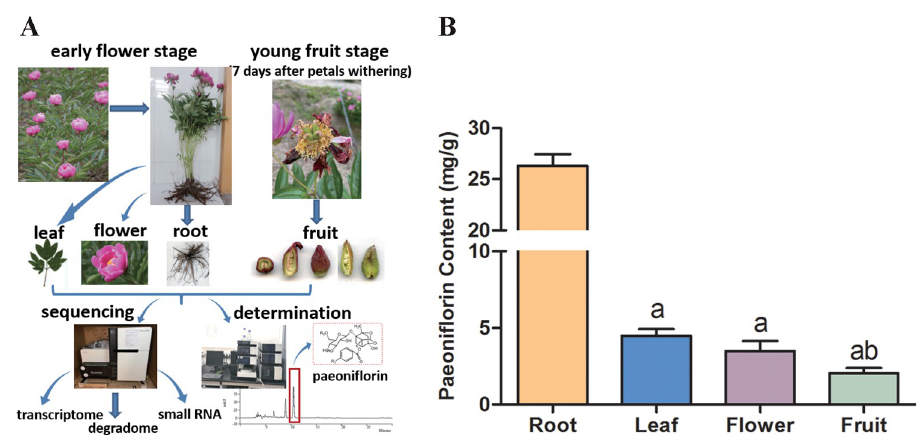
Fig 1. Quantitative analysis of paeoniflorin in different tissues of Paeonia . (A Sampling process and four different tissues of Paeonia , B The contents of paeoniflorin in four different tissues, a represents significant differences at p < 0.05 by comparing root, b represents significant differences at p < 0.05 by comparing leaf).